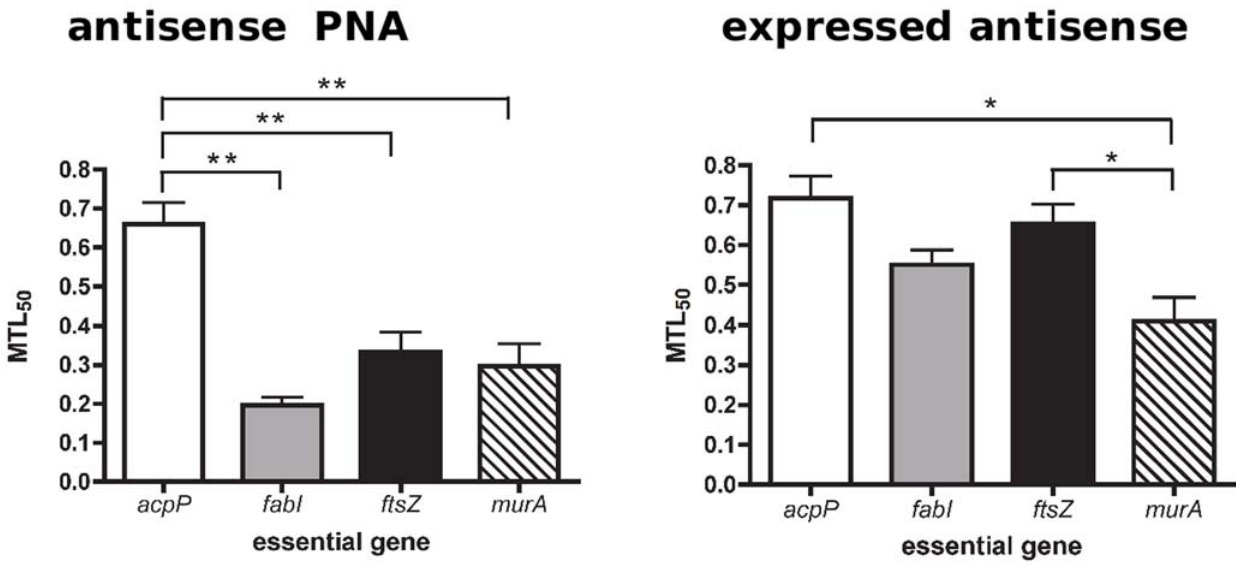
Figure 6. Analysis of essential gene MTL 50 values. Three curves from triplicate experiments of each gene were plotted so as to obtain three MTL 50 values for statistical analyses. Significant difference (**=p , 0.01, *=p , 0.05) in MTL 50 between genes was determined by a one-way ANOVA and Tukey HSD Test. Antisense PNA silencing (left panel) showed MTL 50 of acpP to be significantly greater than the other three genes. Expressed antisense RNA silencing (right panel) showed MTL 50 of acpP and ftsZ was significantly greater than that of murA only.